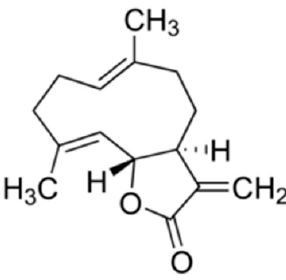
Figure 1. Chemical structure of costunolide (CS).